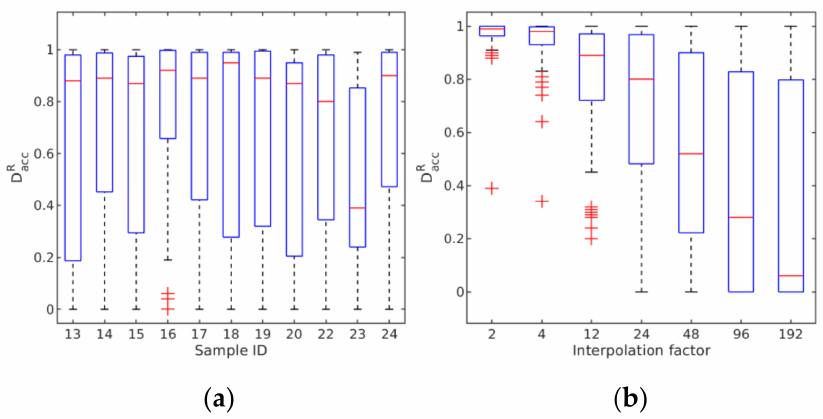
Figure 22. Relative results of overall detection accuracy for all interpolation methods and all considered joint conditions, specifically ( a ) for each workpiece and ( b ) for individual interpolation